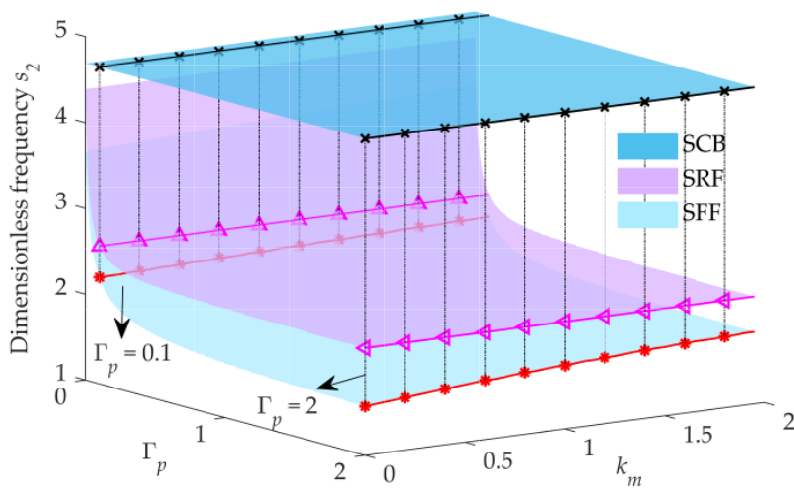
Γ p ( M p = 0.1). k and  m k and  m